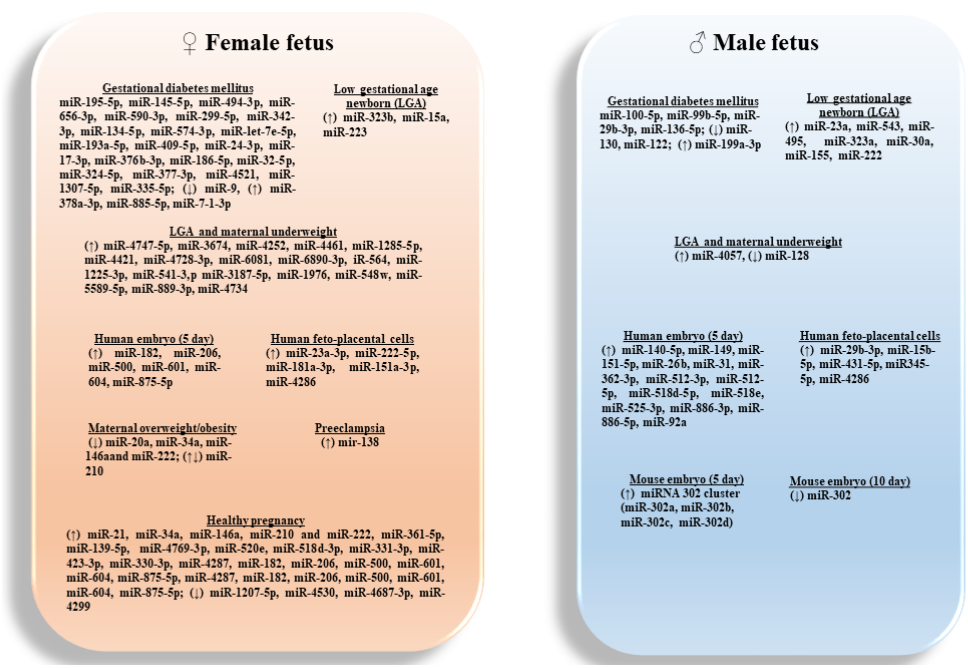
Figure 2. Sex-specific associated of candidate miRNAs expressed in placentas, amniotic fluids and embryos, with pregnancy-related